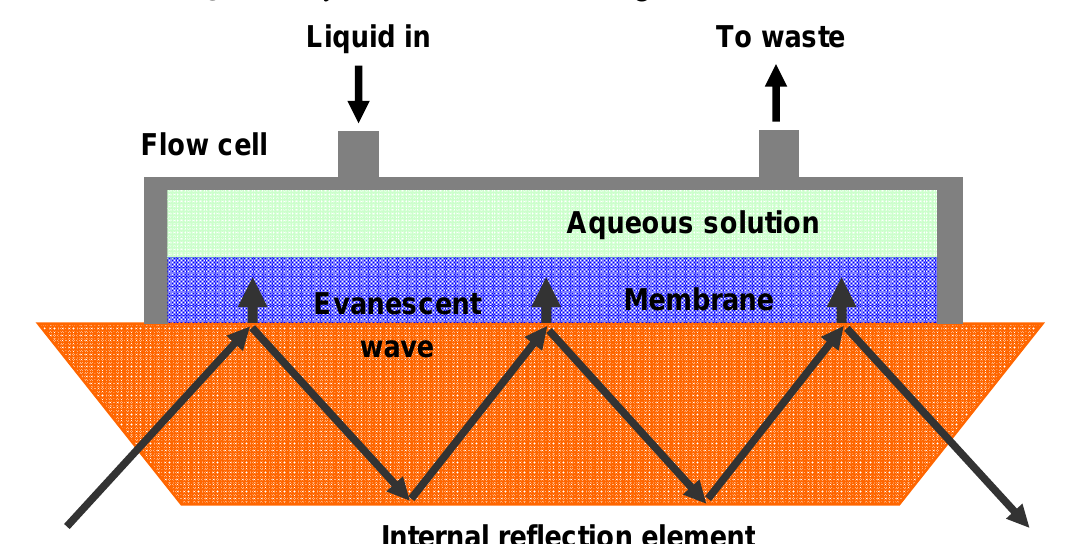
Figure 3. Hydrocarbon detection using an MIR-ATR